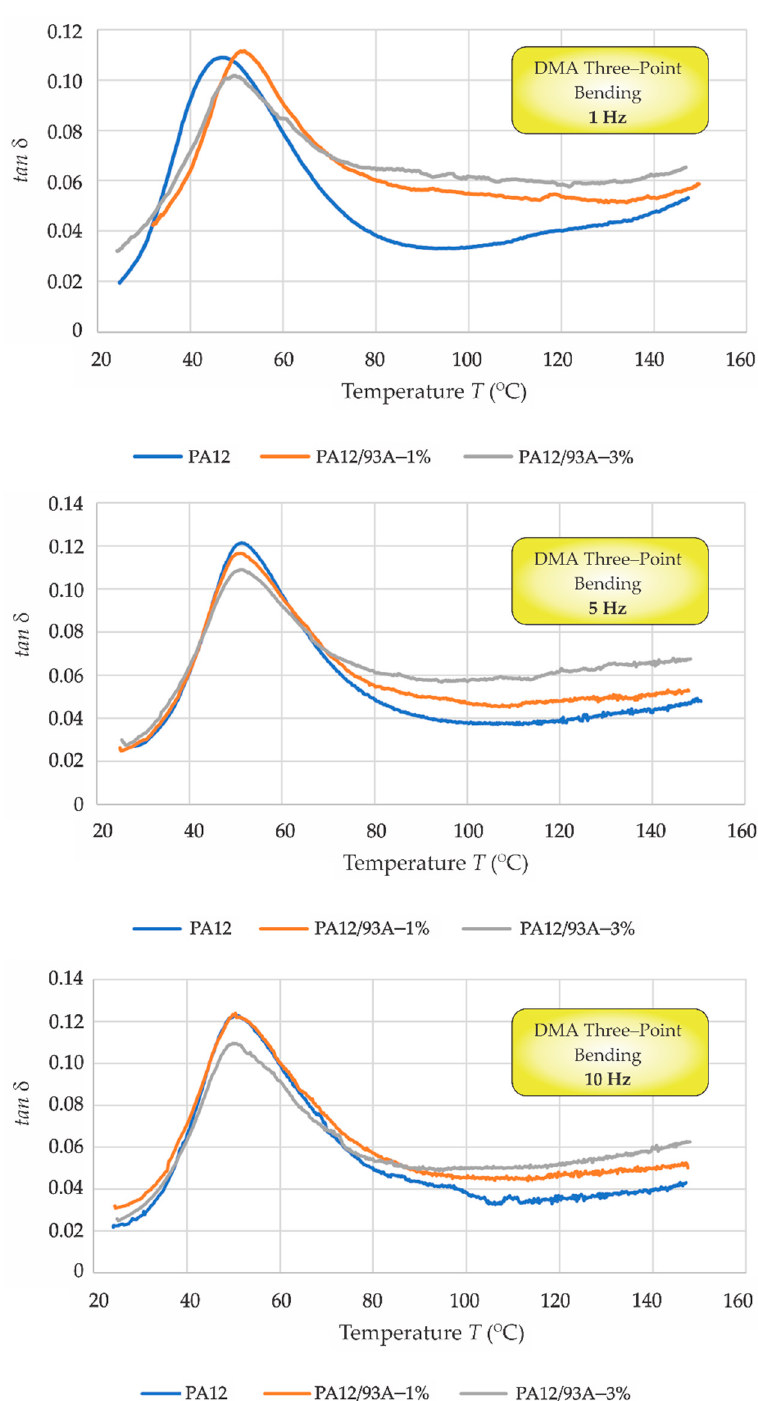
Figure 8. DMA three-point bending: tan δ versus temperature ( T ) at 1 Hz ( top ), 5 Hz ( middle ) and 10 Hz ( bottom ).